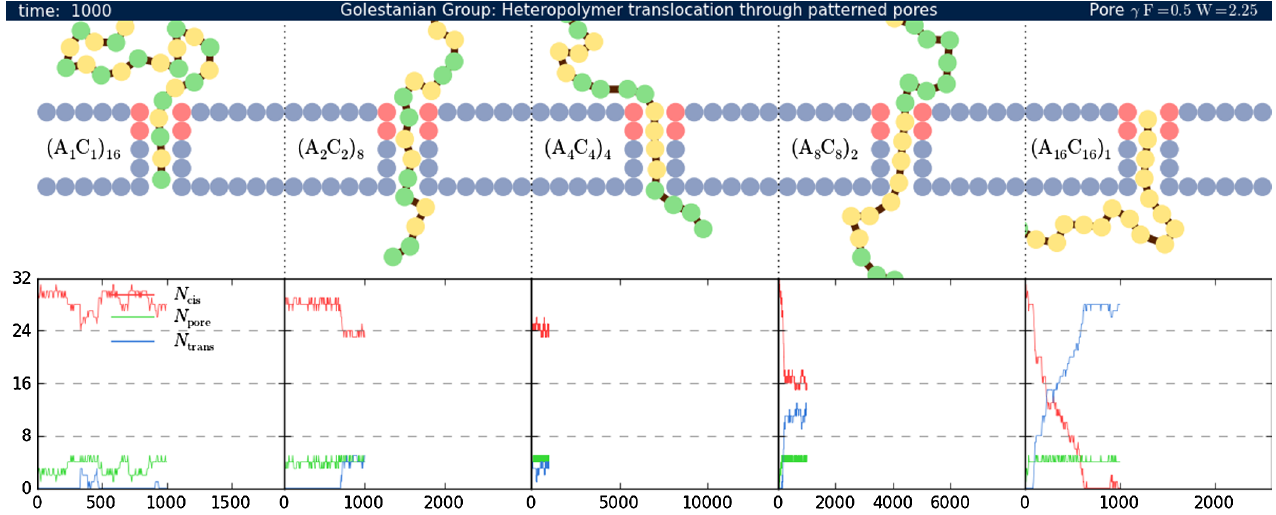
VIDEO 3. Heteropolymers of length N ¼ 32 with block lengths 1, 2, 4, 8 and 16 translocating through Pore (cid:2) . Monomer type A (yellow) has an interaction energy three times larger than that of B (green). The top panel shows a view of the simulation near the pore region, which consists of attractive (red) and short-range repulsive (blue) patches. Pore (cid:2) is asymmetric with an attractive entrance. The total number of monomers in the cis (red), pore (green), and trans (blue) side are counted as a function of time in the lower plot. The runs selected have a translocation time near that of the mean translocation time for the particular structure. The parameters, as explained in the paper, are W ¼ 2 : 25 and F ¼ 1 : 0